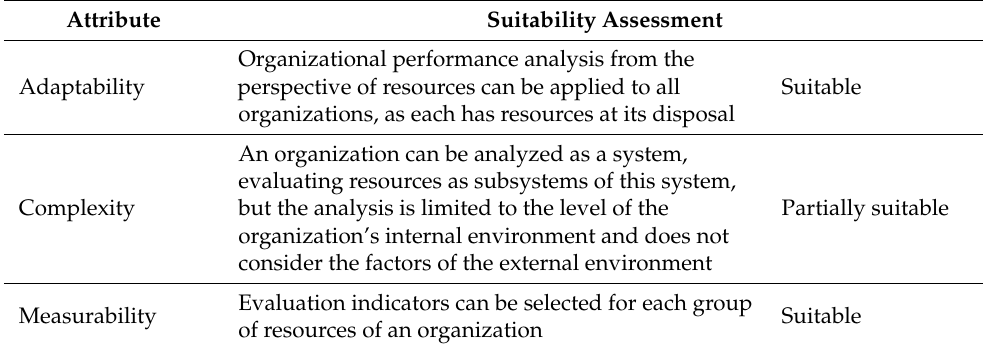
Suitable Partially